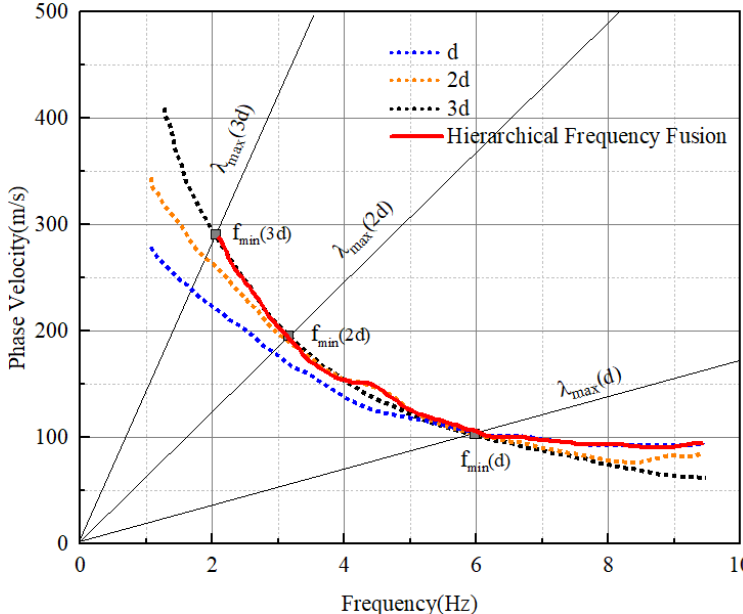
Figure 5. The schematic of hierarchical frequency fusion.